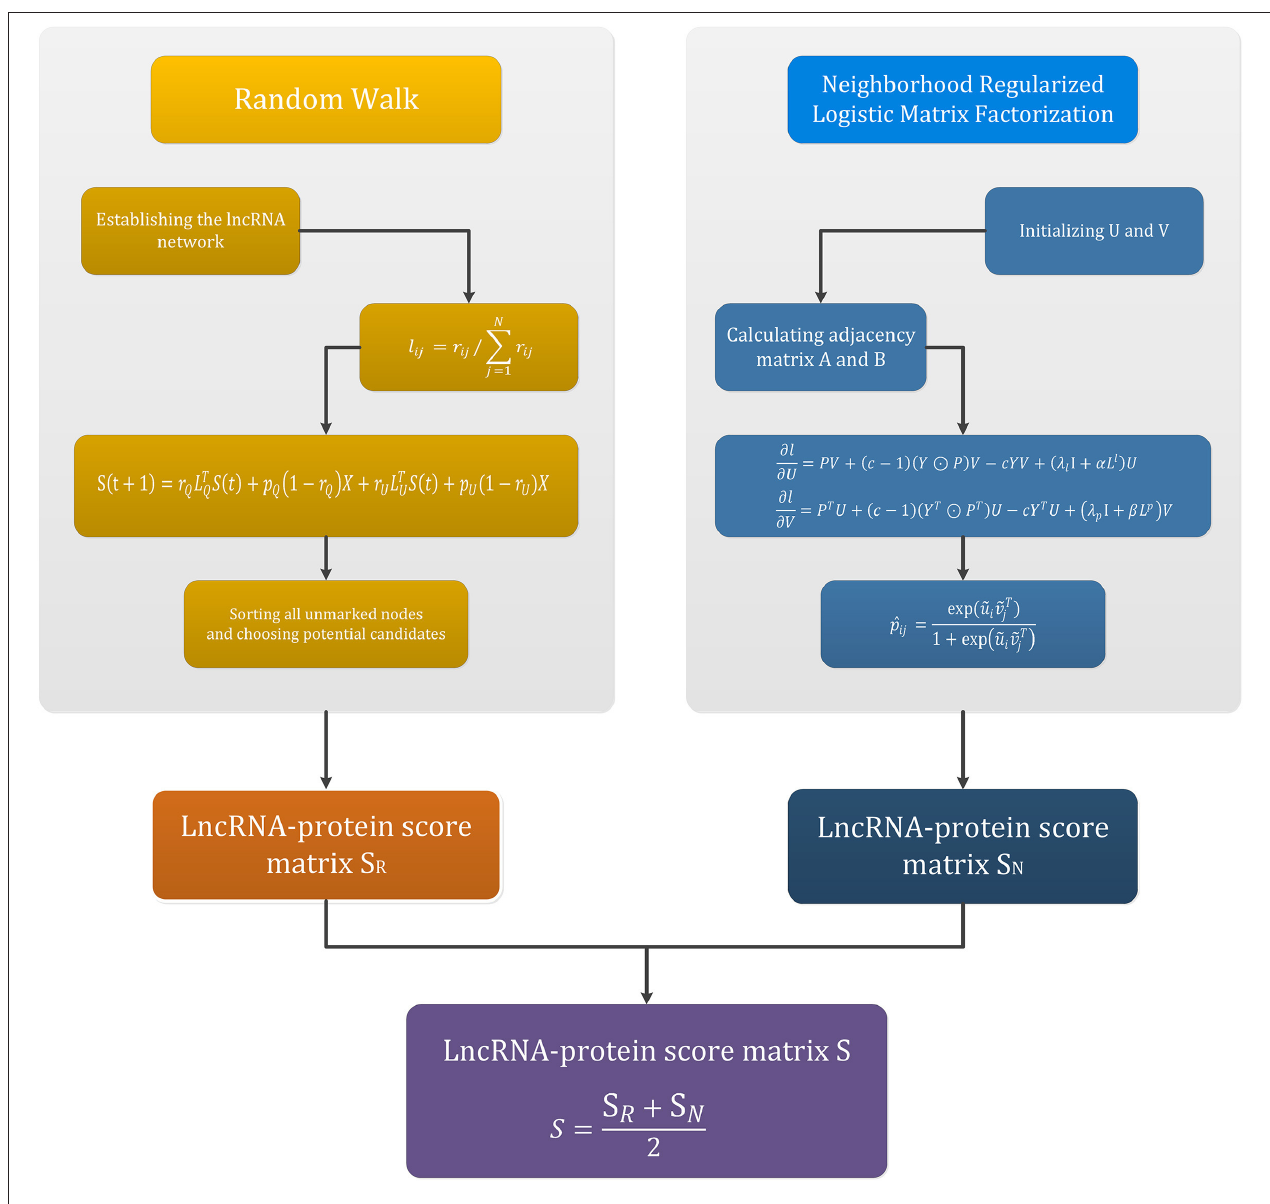
FIGURE 2 | The process of constructing the integrating